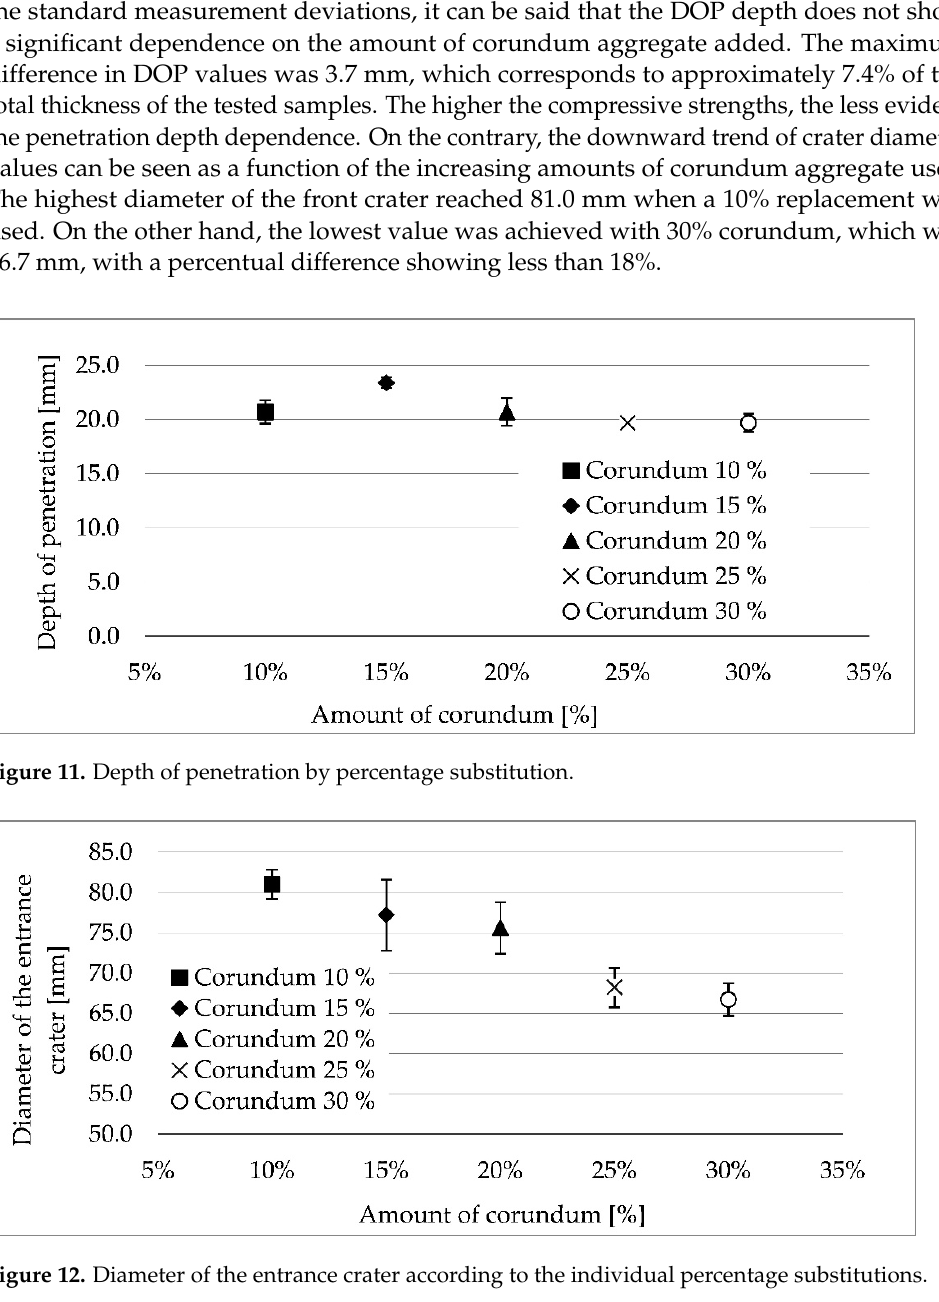
Figure 10. Spatial visualisation of the formed crater.